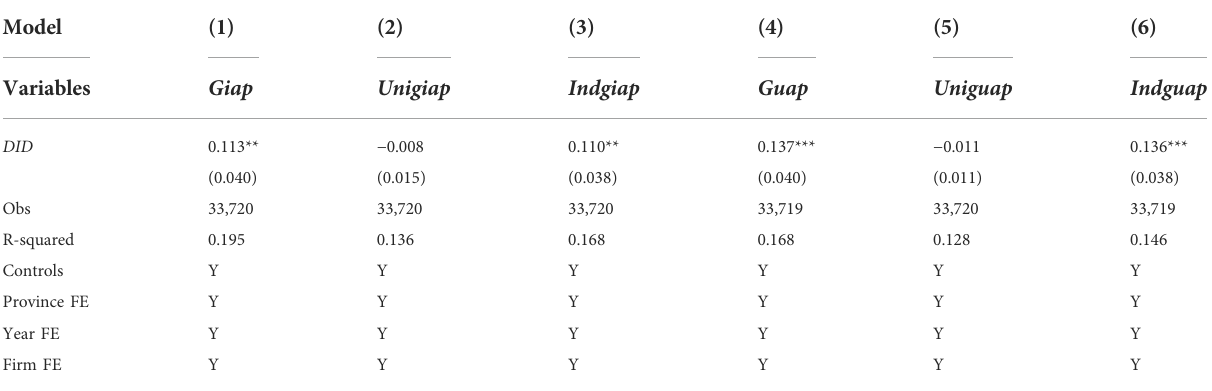
TABLE 9 Patent type heterogeneity estimation results.